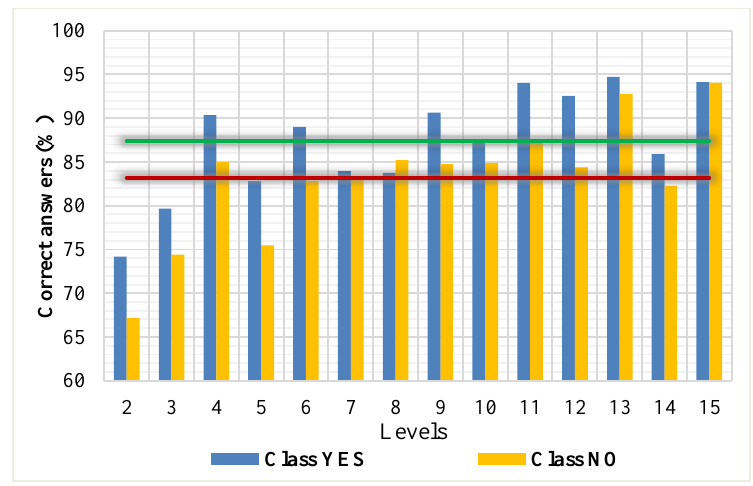
Fig. 2. Accuracy in solving the tasks for students taking additional classes in Mathematics (class YES) and those taking regular classes only (class NO) in the game “Zagonetke mudrog lisca“